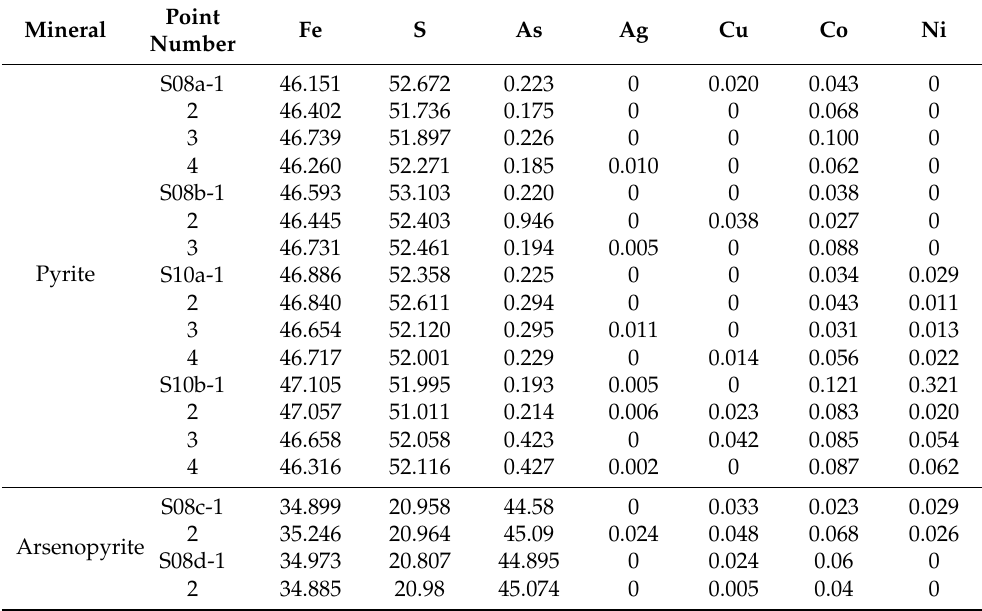
Table 4. EMPA results of pyrite and arsenopyrite in the first metallogenic stage. Mineral